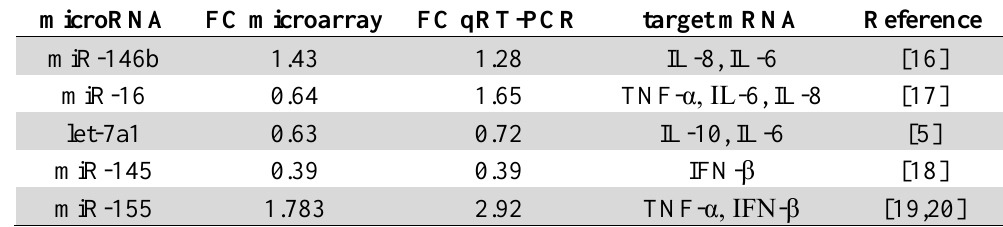
Table 1. Comparison of fold changes of candidate miRNAs that were identified using miRNA microarrays and validated by qRT-PCR. and target mRNAs of each miRNA. The fold changes were display the relative miRNA expression in infected Caco-2 cells 1 h following infection with L. monocytogenes and control